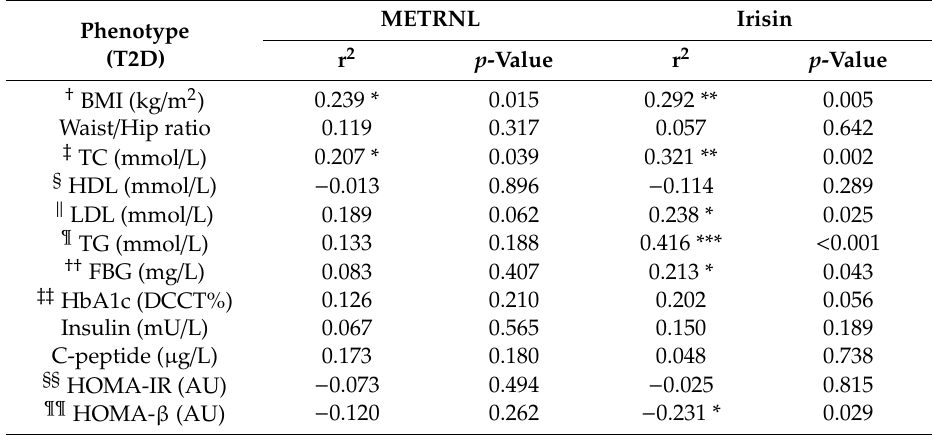
Table 5. Correlation between circulating METRNL and irisin proteins and physical, clinical, and biochemical parameters in T2D population adjusted for age and gender.